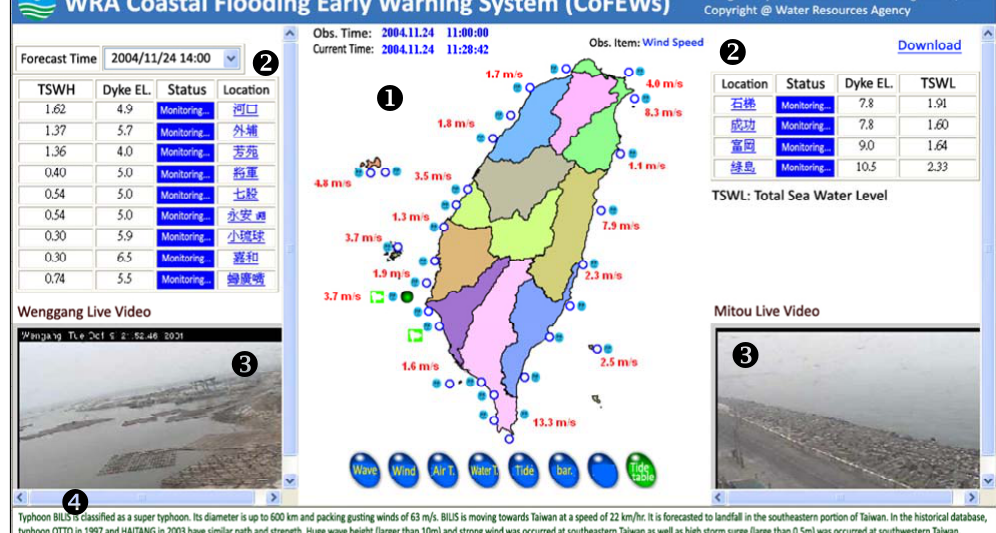
Figure 12 Main page of CoFEWs. Four parts are presented in this page. They are  Real-time Sea States (RSS); Forecast Storm Level Real-time Sea States (RSS);  Forecast Storm Level (FSL);  Live Video Image (LVI); and  Historical Typhoon Events (THE)